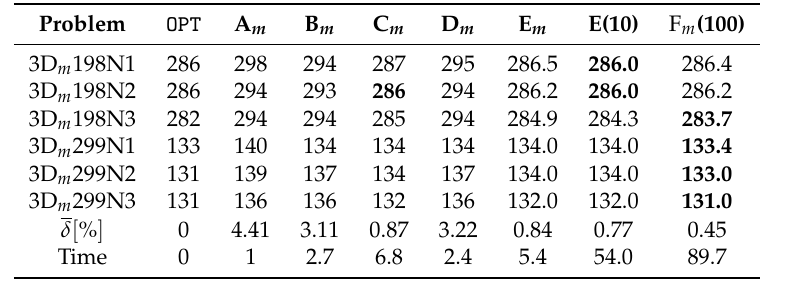
Table 4. Numerical result for Algorithms A m , B m , and C m on the second group of instances from [30] (called binary graphs). The optimum values OPT are taken from [30], and the values val are